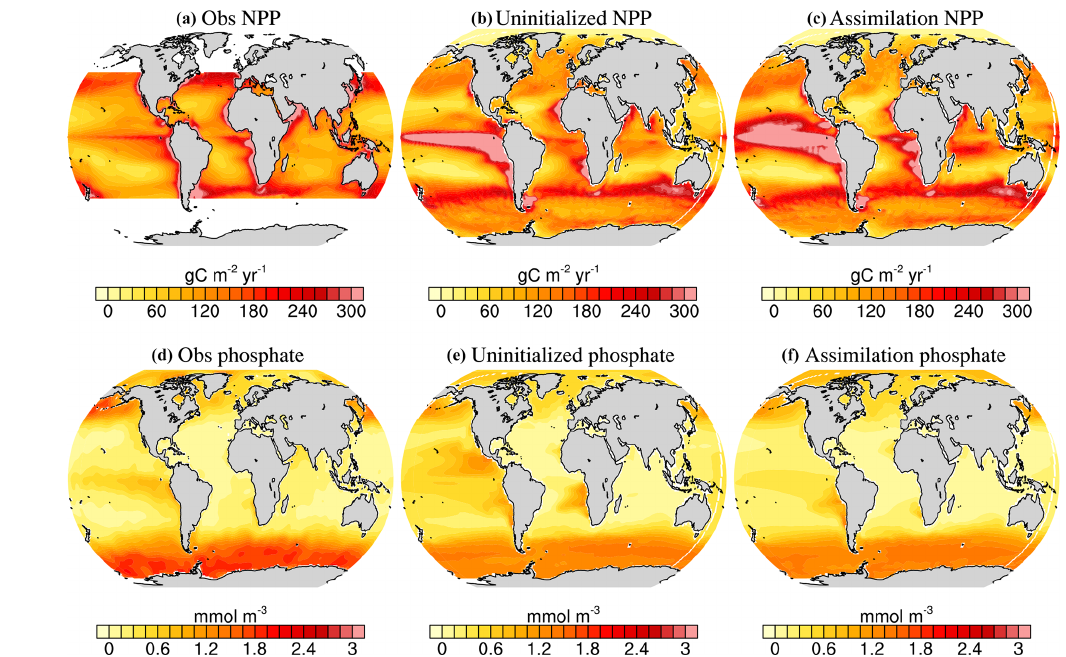
Figure A2. Climatological mean of ocean net primary production (NPP, a–c ) and phosphate concentration (d–f) from observations and from model simulations. Observation-based NPP data are estimated from ocean color measurements obtained by the Sea-viewing Wide Field-of-view Sensor (SeaWiFS) instrument of the OrbView-2 satellite for the September 1997–December 2002 period and the Moderate Resolution Imaging Spectroradiometer (MODIS) of the Aqua satellite for the 2003–2014 period (Behrenfeld and Falkowski, 1997, http: //science.oregonstate.edu/ocean.productivity/index.php, last access: 12 November 2019). Phosphate observations are from the World Ocean Atlas 2018 (Garcia et al., 2019). The corresponding NPP data from model simulations are averaged over the 1998–2017 period, and phosphate data are averaged over the 1970–2018 period according to the availability of the observation data.